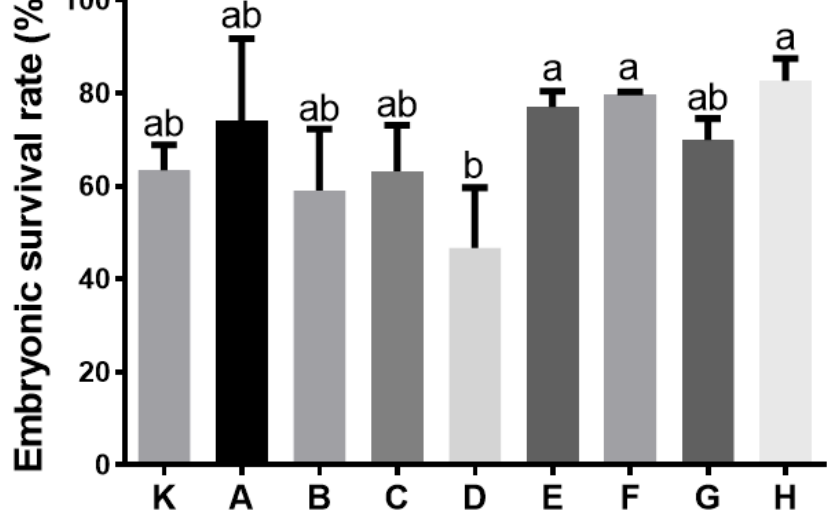
Figure 2. Determination of the influence of different activating buffers on the perch embryonic survival rate (72 h after fertilisation) (K—control, hatchery water; A—„Lahnsteiner” liquid, pH 7.0, 100 mM NaCl, 10 mM Tri; B—„Lahnsteiner” liquid, pH 8.0; C—„Lahnsteiner” liquid, pH 9.0; D— 10